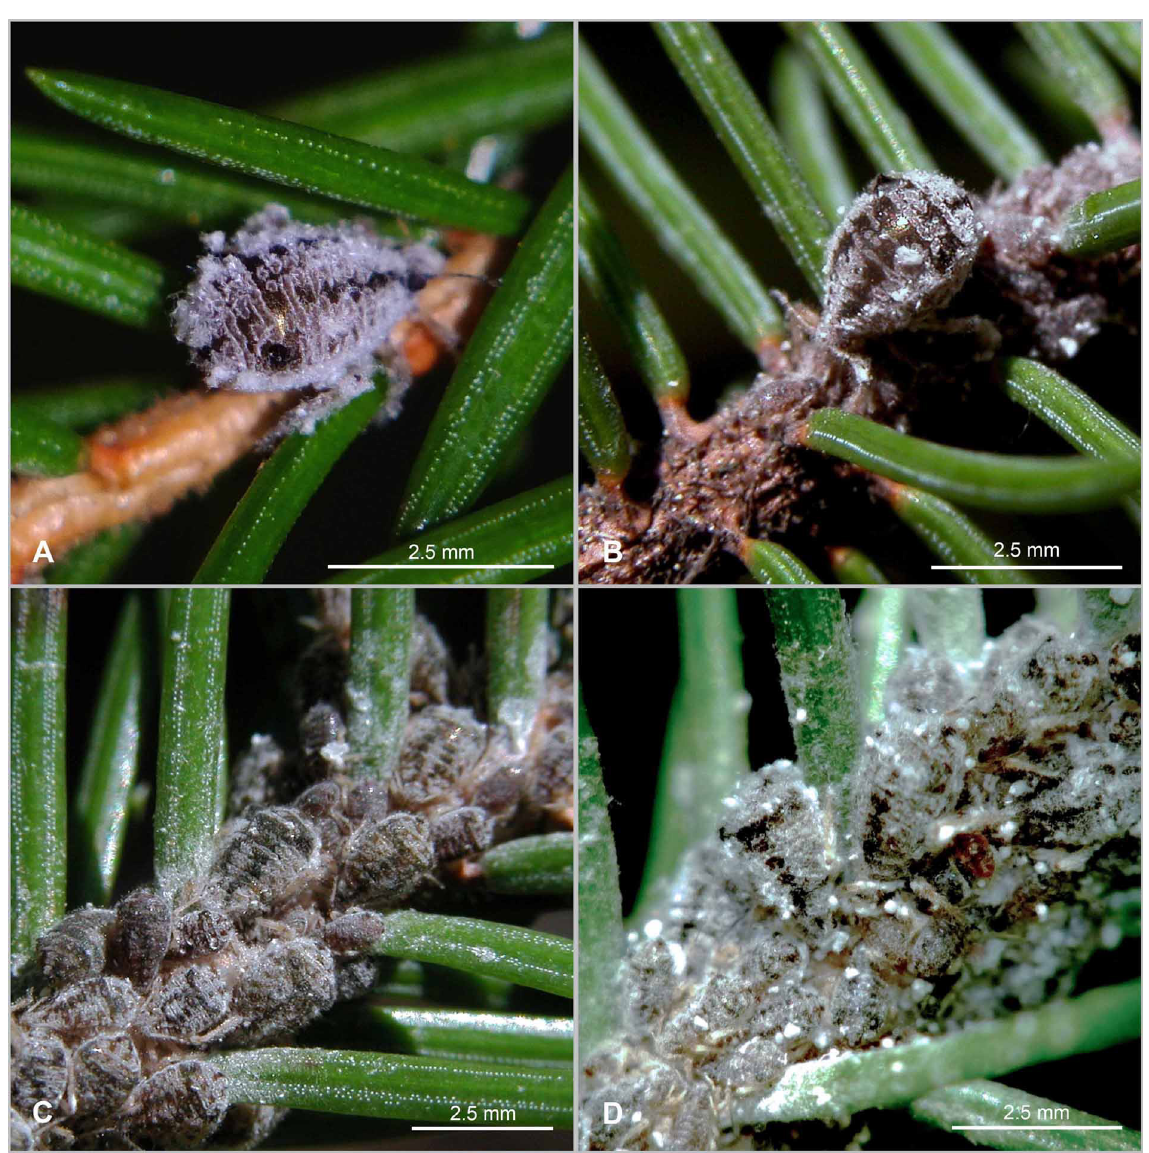
Fig. 33. Cinara (Cinara) costata (Zetterstedt, 1828) on Picea abies , showing different stages of development and deterioration of wax